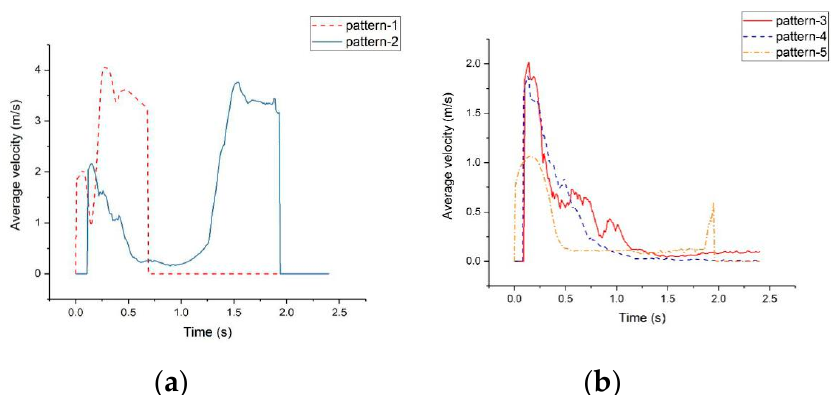
Figure 10. Different particle flow patterns under three cases. ( a ) Particles that can be transported and ( b ) particles that failed to transport.